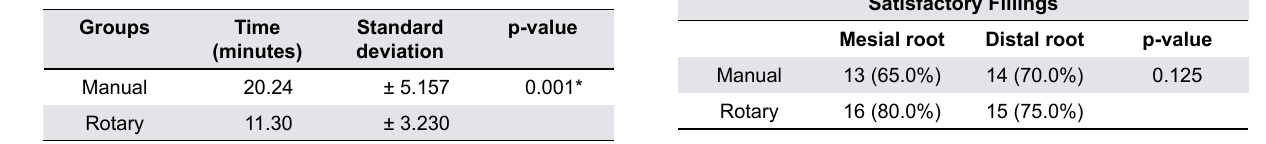
Table 2- Analysis of the instrumentation time required for the biomechanical preparation of root canals and standard deviation by manual and rotary techniques